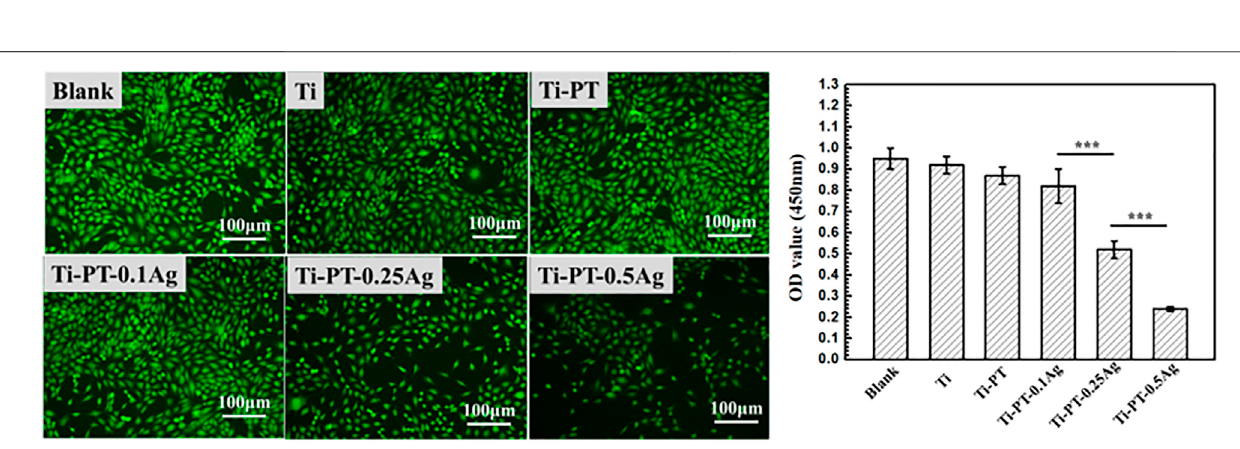
Frontiers in Bioengineering and Biotechnology |